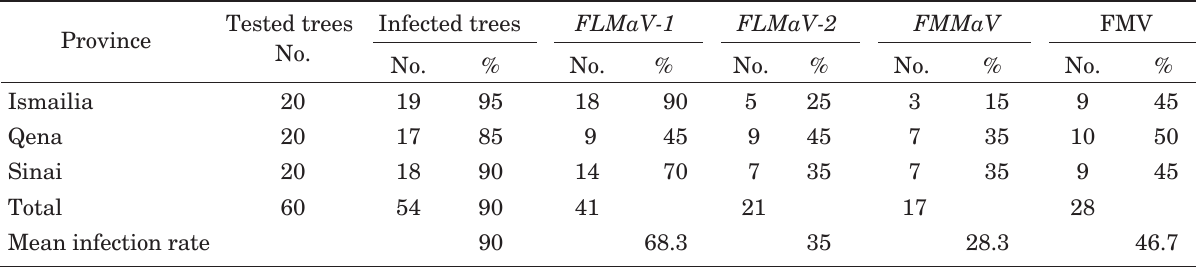
Table 1. Incidence of FLMaV-1 , FLMaV-2 , FMMaV and FMV infections in three fi g-growing provinces of Egypt as determined by RT-PCR assays. Tested trees Infected trees FLMaV-1 Province